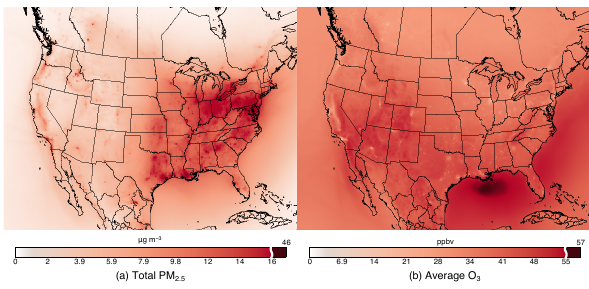
Figure 1. Modeled annual average ground level (a) PM 2 . 5 and (b) O 3 concentrations. For ease of viewing, the color scales con- tain a break at the 99th percentile of